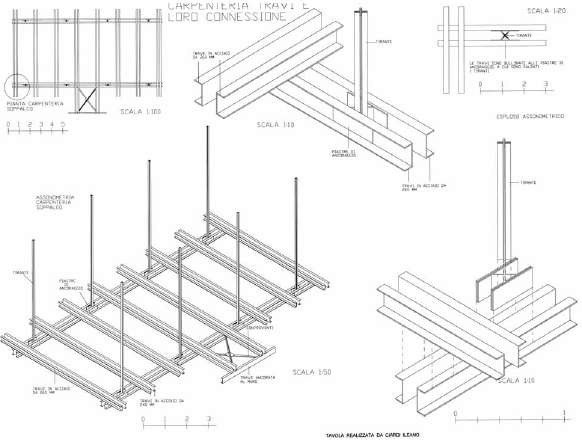
Figure 17. Axonometric view of the carpentry.